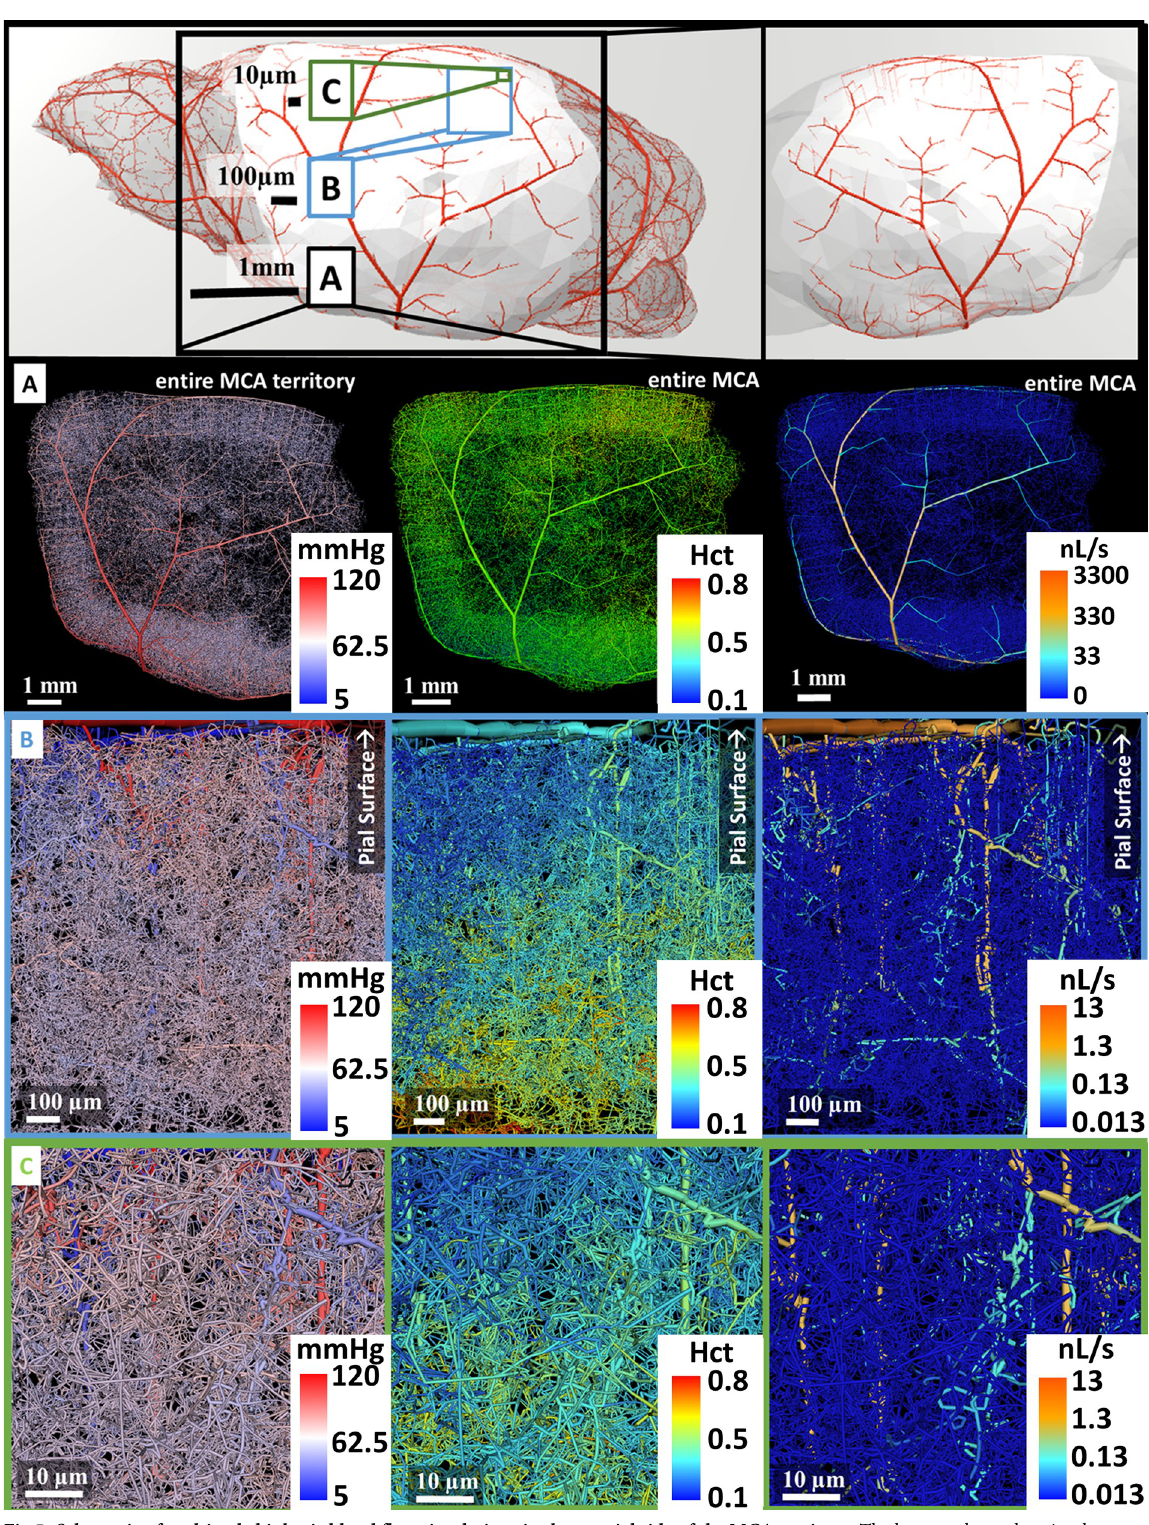
Fig 5. Schematic of multiscale biphasic blood flow simulations in the arterial side of the MCA territory. The large-scale cerebrocirculatory model connects the Circle of Willis to the territory of the middle cerebral artery with its complete pial arterial network and microvasculature. Simulation results show snapshots of pressure distribution, flow rates, and hematocrit at three length scales (1mm, 100 μ m, 10 μ m). The three